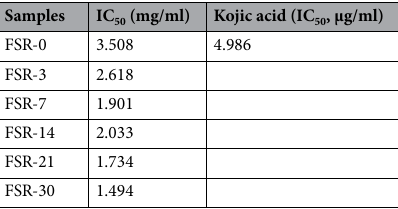
Table 4. IC 50 values for tyrosinase inhibition by fermentation solution of Rosa ‘Dianhong’ (FSR).